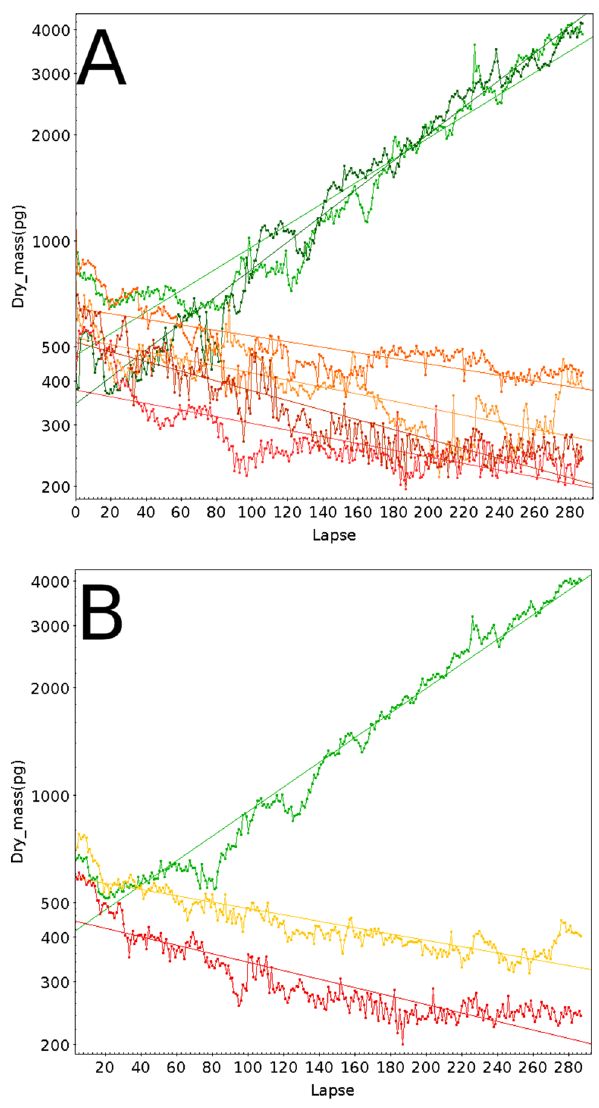
Figure 5. 6-day live monitoring of REF populations in the presence of increasing staurosporine (STS) concentrations. Green: 0 nM STS; orange: 4 nM STS; red: 20 nM STS. ( A ) Each line on these plots corresponds to the monitoring of one field encompassing multiple cells together with its linear fit (same color), and each STS concentration was monitored on 2 fields with initial seeding of the 24-plate with 20,000 cells. ( B ) Average of the 2 fields of the 3 conditions monitored in ( A ), with the same color code. Green: 0 nM STS, orange: 4 nM STS; red: 20 nM